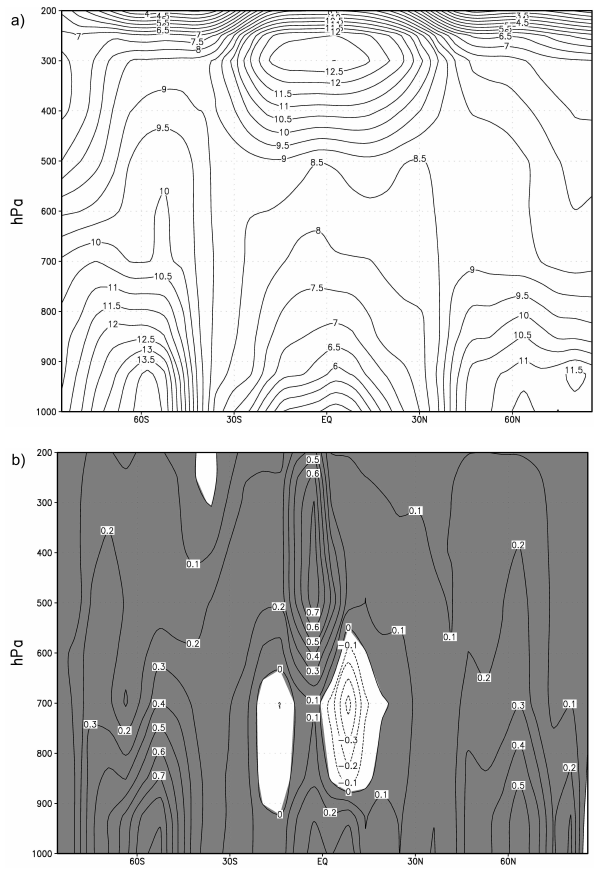
Fig. 5. (a) Zonally averaged mean temperature difference between the 1000ppm CO 2 and 100ppm CO 2 concentration runs. (b) Zon- ally averaged difference between the 1000ppm CO 2 and 100ppm CO 2 concentration runs for the mean heating rates due to the con- vergence of latent heat fluxes (in K/day).